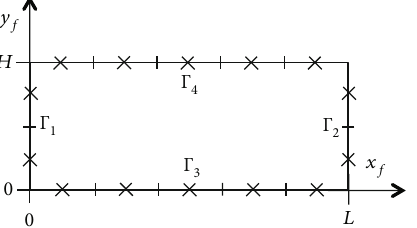
Figure 2: Illustration ofa subfracture having length L , width H ,local coordinates x and y , and discretized borders Γ f f the discretization nodes are represented with